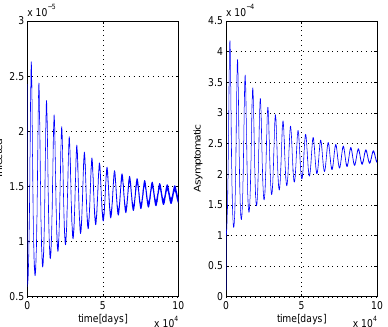
Fig. 3: Sustained oscillations, can be observed for = γ = γ γ = γ = γ = γ , 1 /γ ∈ , 1 /γ ∈ (3 , 7) , (cid:60) 1 2 3 1 2 3 k ≥ 3 , p = 0 . 2 , σ = 0 . 2 .